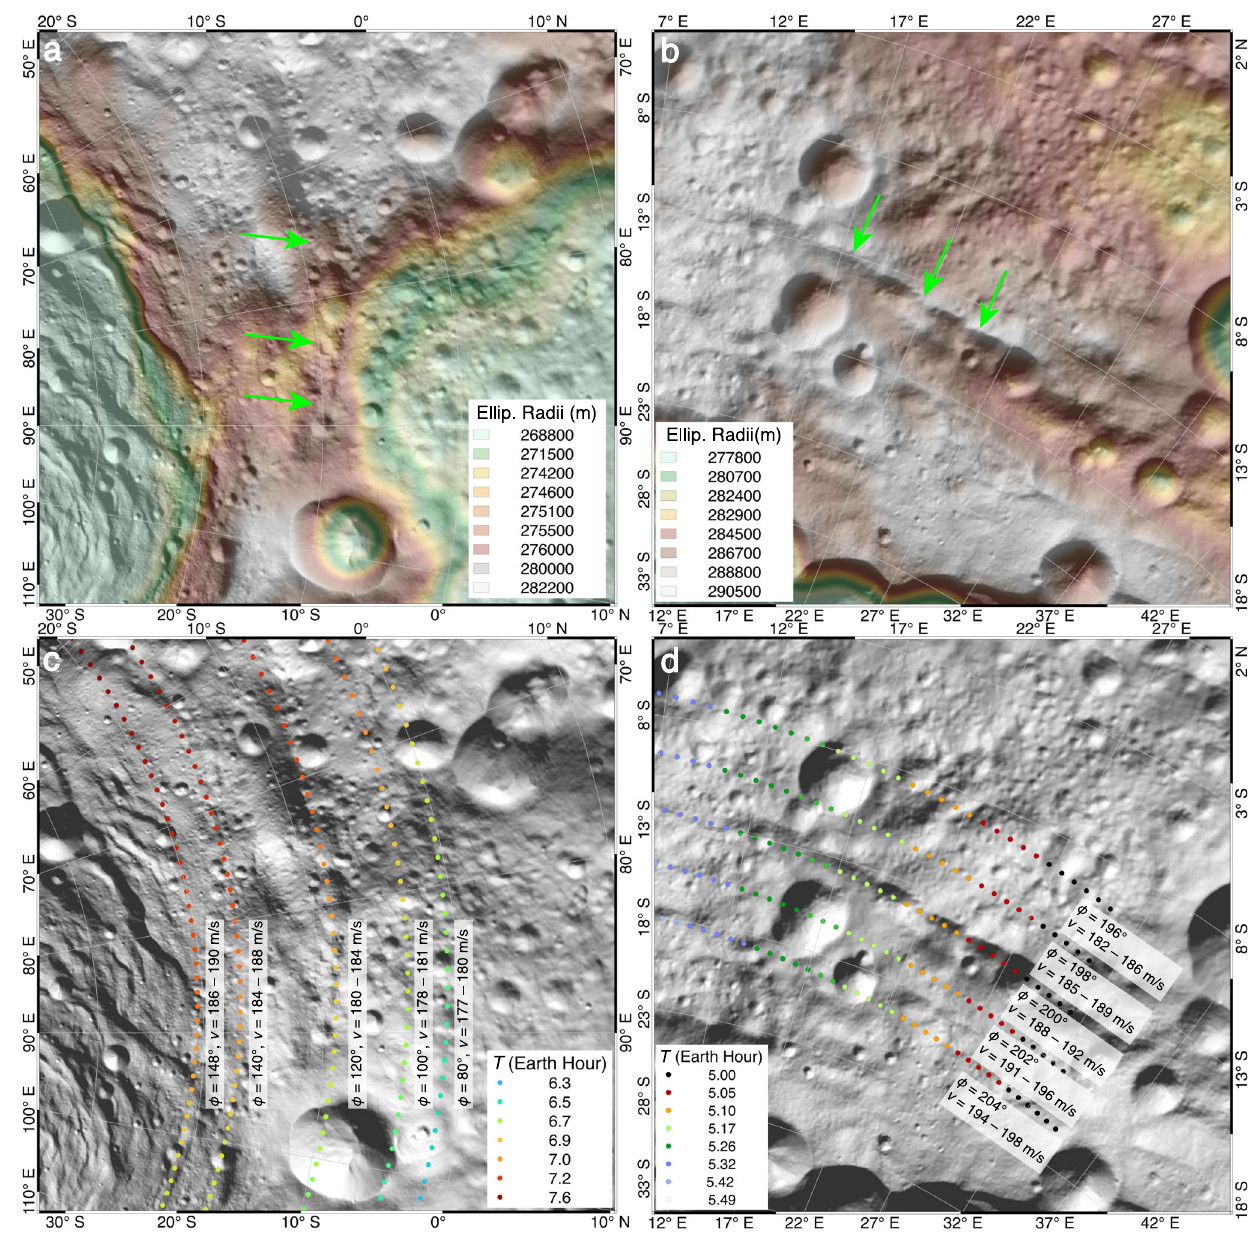
Fig. 8 | Somecircumferentialtroughs onwallsand rims oftheRheasilvia basin at the south pole of4Vesta may be formedby secondary impacts. a , b Many of the troughs occur aspitchains thathave raised rims (greenarrows). c , d Predicted landing positions of ejecta from the Rheasilvia basin can occur along the roughs.